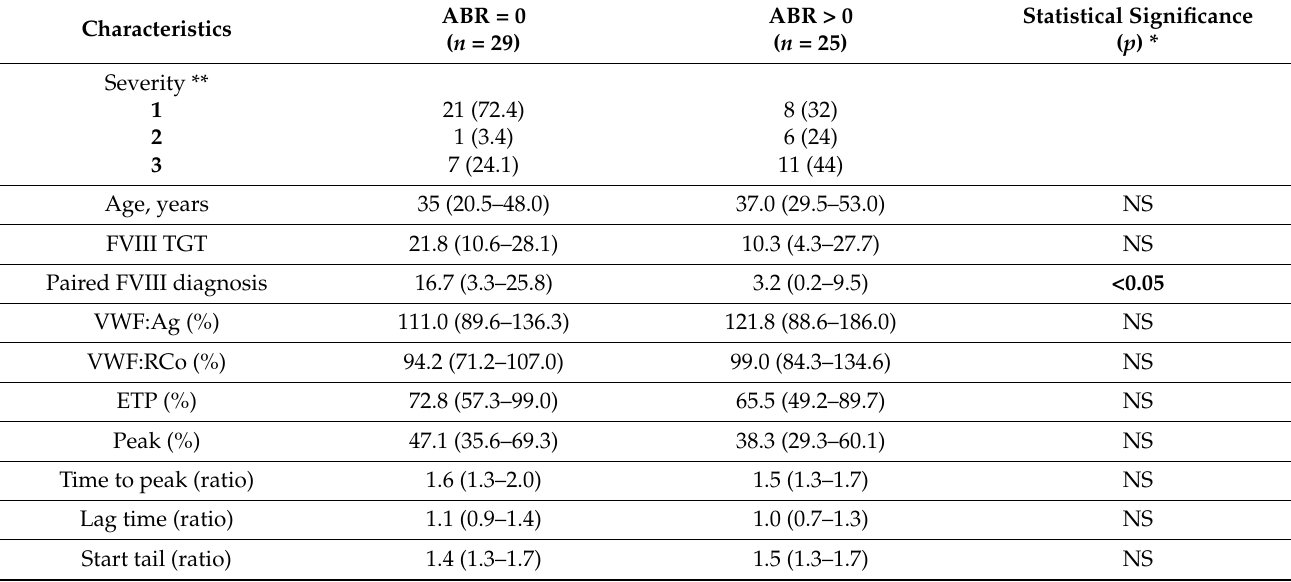
Table 4. Clinical characteristics of the HA patients according to the ABR